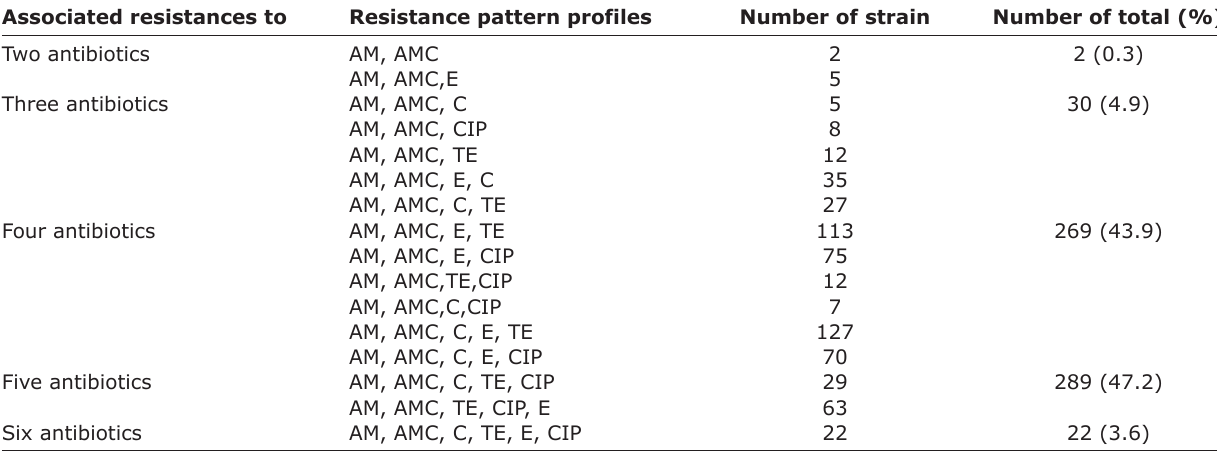
Table-4: Resistance pattern profiles of isolated thermotolerant Campylobacter strains. Associated resistances